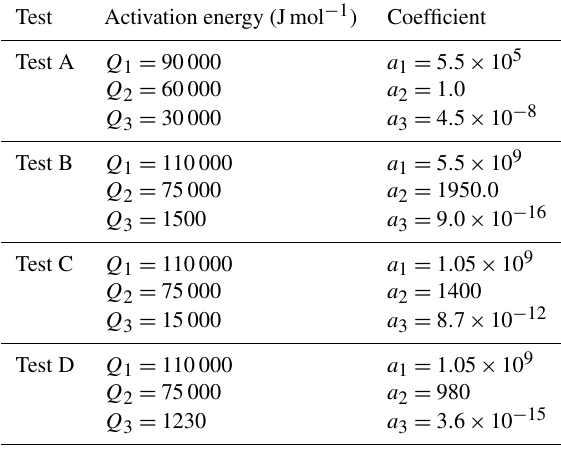
Table 2. Values used for the different sensitivity tests for three activation energies. These values have been chosen to illustrate the effects of varying activation energies for the different temper- ature ranges on the densification rate for the different ice core deep drilling sites (see Fig. 8) and to support the tuning presented in Ta- ble